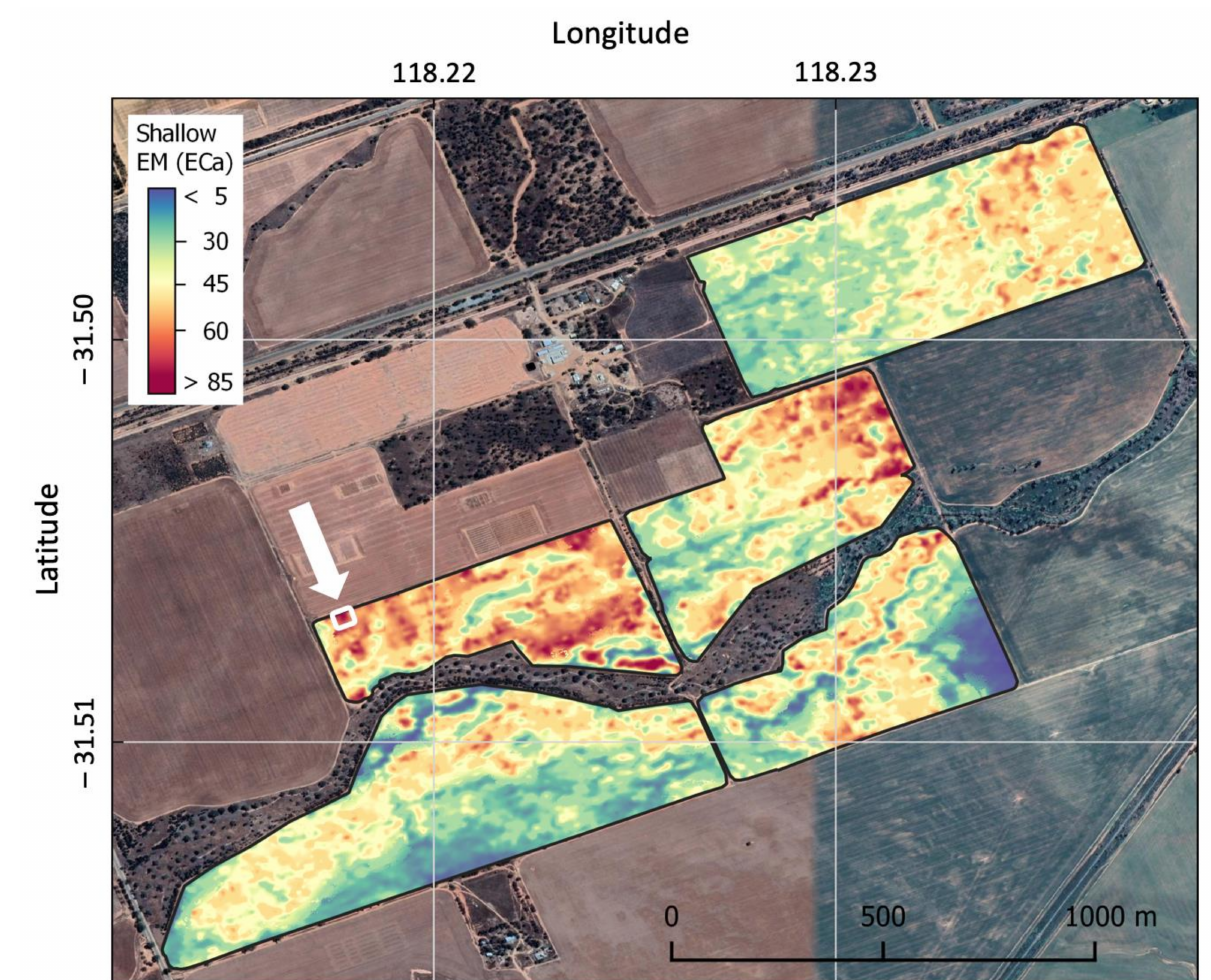
Figure 1. Variation in apparent electrical conductivity (EC a ) measured at the paddock scale with a DualEM (the 50 cm dipole) at Merredin Research Station on 9 April 2019. The trial was located in the white square indicated by the